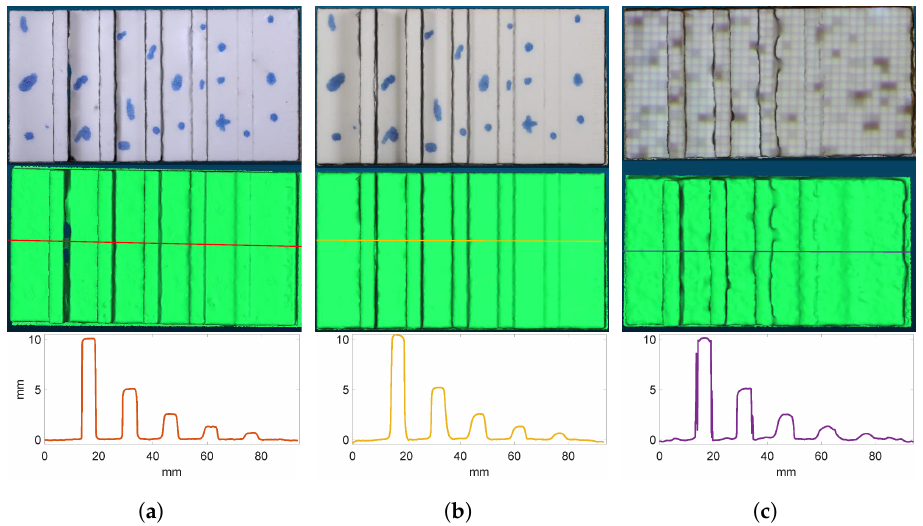
Figure 5. The reconstructed step-height artifact. The reconstructions in ( a ) at 1.5 m and in ( b ) at 2.0 m range are of the manually marked artifact. In ( c ), the reconstruction using a projected pattern over the artifact is shown. The top and middle row shows the reconstruction with and without color texture. In the bottom row, a line profile is shown across the artifact with the position indicated by the line in the middle